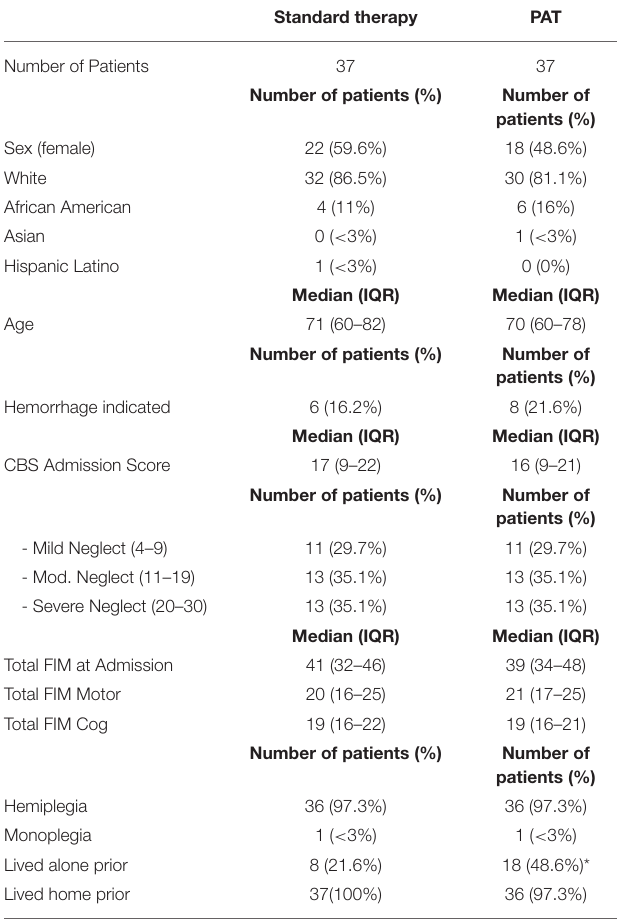
TABLE 1 | Admission characteristics of patients who received standard or Prism Adaptation Treatment (PAT). Standard therapy PAT